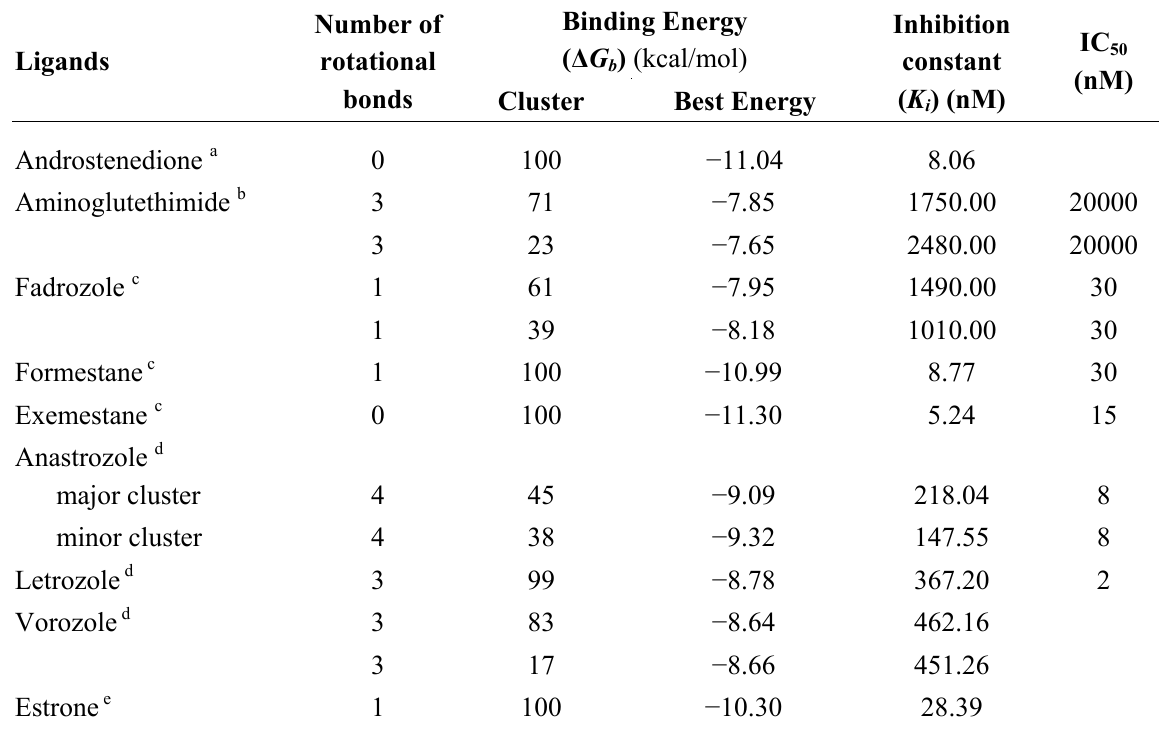
Table 1. The approximate free energies of binding ( Δ G calculated by AutoDock along with their experimental inhibition concentration (IC